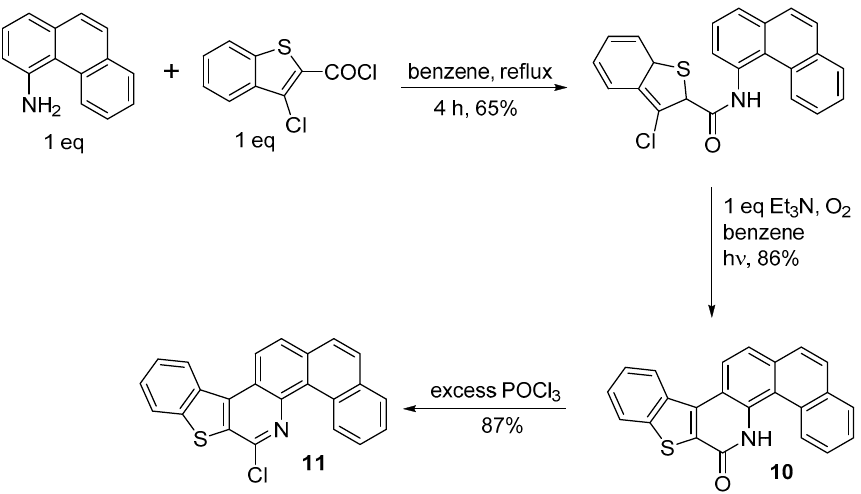
Scheme 9. Synthesis of 8-chlorobenzo[4,5]thieno[2,3-c]naphtho[2,1-h]quinoline 11